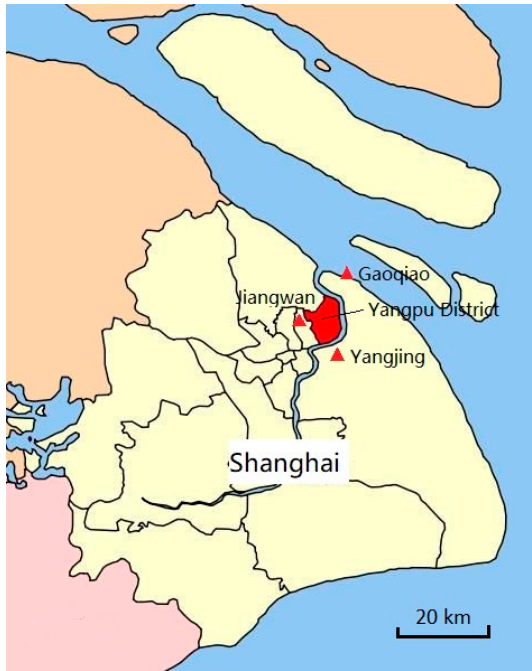
Figure 1. Location of Yangpu District. Triangles denote rain gauges whose data are used in the